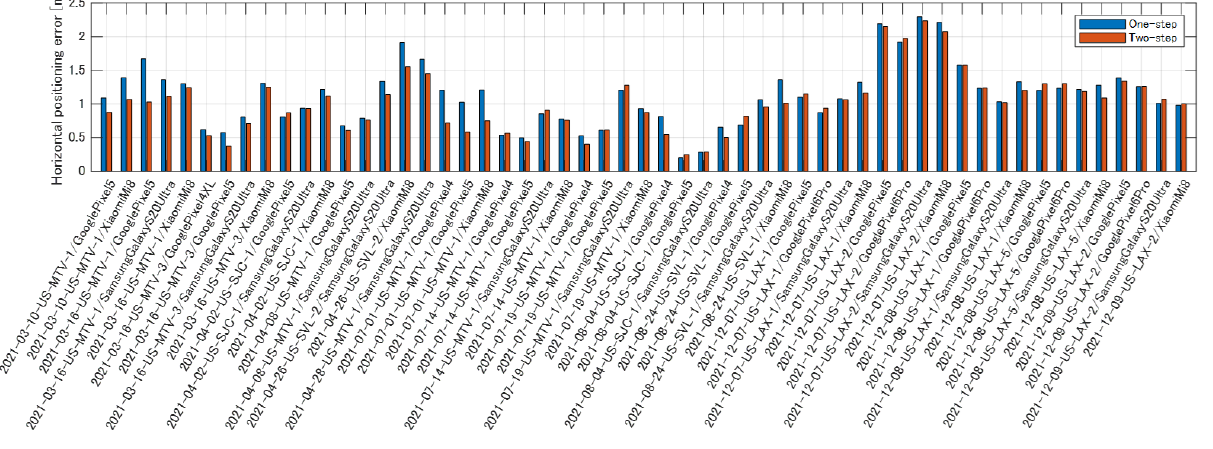
Figure 11. Comparison of positioning error between one-step and two-step optimization. Table 3. Summary of positioning error comparison between one-step and two-step